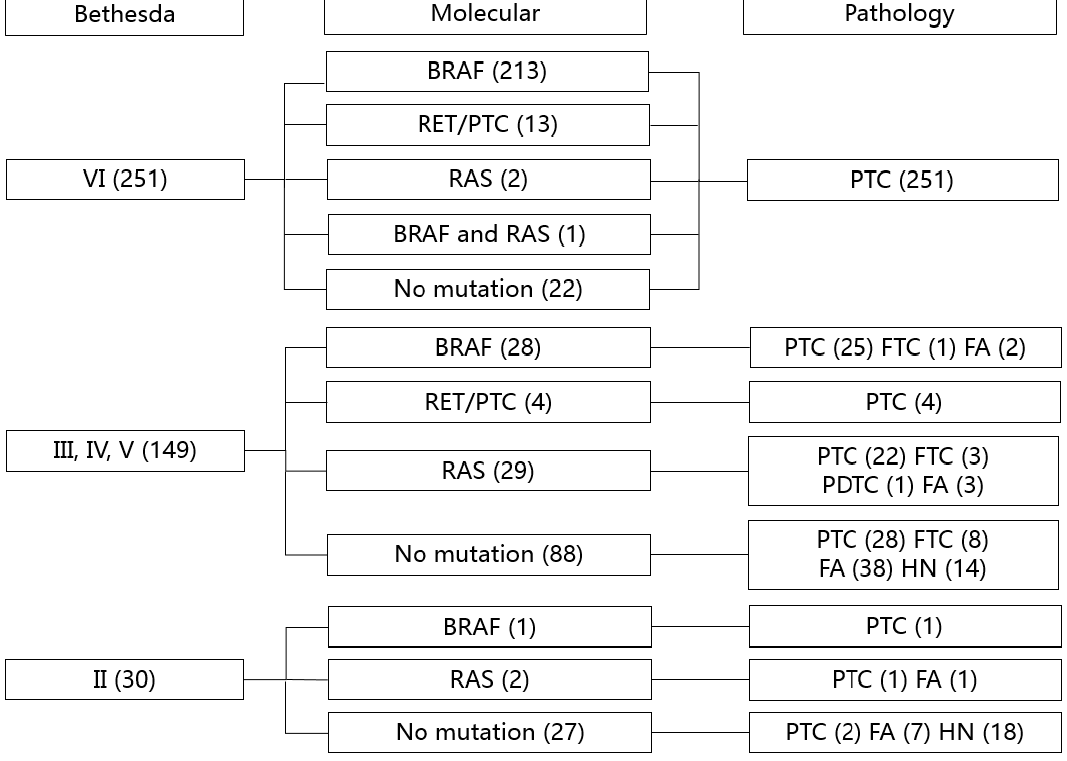
Figure 1. Correlation between cytology, molecular, and pathology diagnosis in 430 FNA specimens. FNA, fine-needle aspiration; PTC, papillary thyroid carcinoma; FTC, follicular thyroid carcinoma; PDTC, poorly differentiated thyroid carcinoma; FA, follicular adenoma; HN, hyperplastic nodule. Table 2. Comparison of diagnostic performance between cytology and molecular testing. Diagnostic Performance (%) Diagnosis Sensitivity Specificity PPV NPV Accuracy